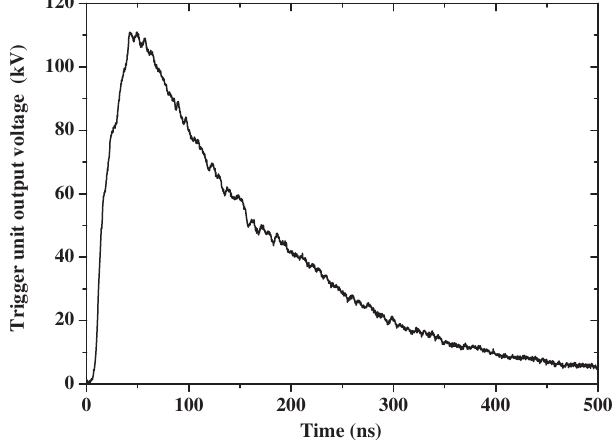
FIG. 4. The output voltage of the trigger unit. The maximum value and 10 – 90% rise time are about 110 kV and 27.3 ns,